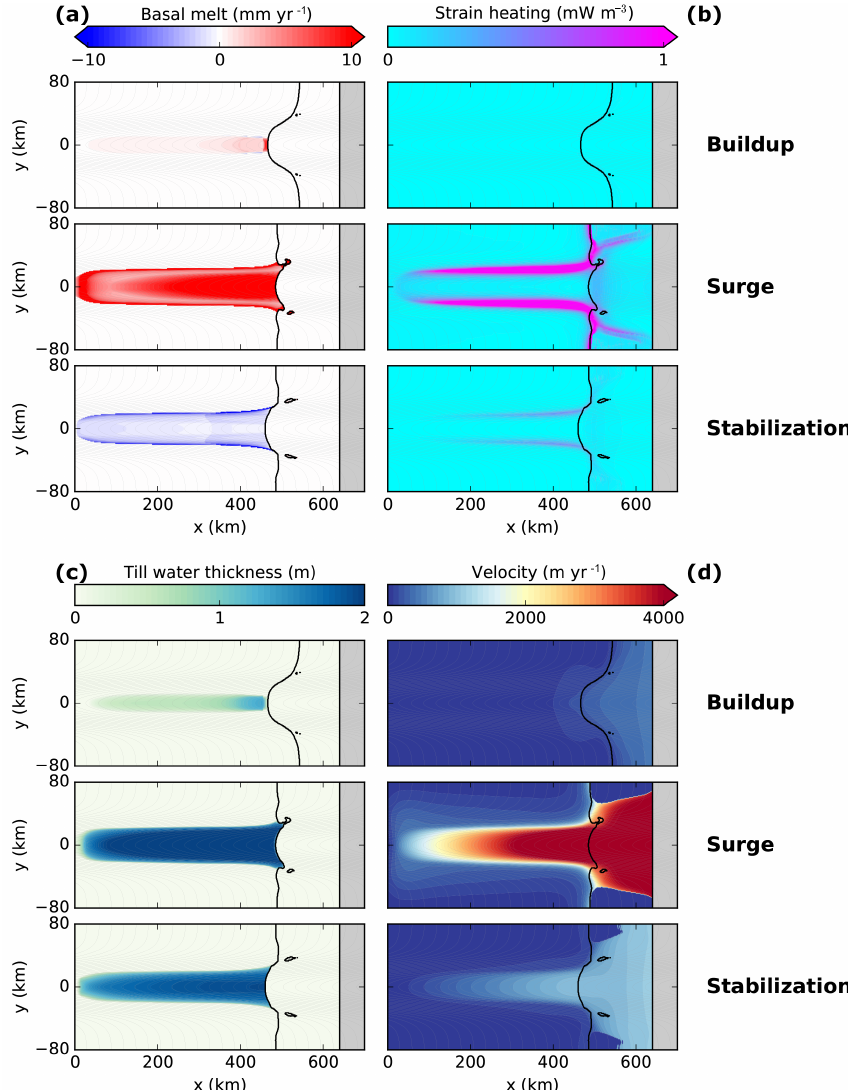
Figure 4. Fields of (a) basal melt rate m , (b) strain heating, (c) till water thickness W till and (d) velocity for a representative snapshot for each of the three phases of buildup, surge and stabilization (as denoted by the colored circles in Fig. 3). Thick black contours mark the grounding line and calving front. Bed topography shown by thin gray